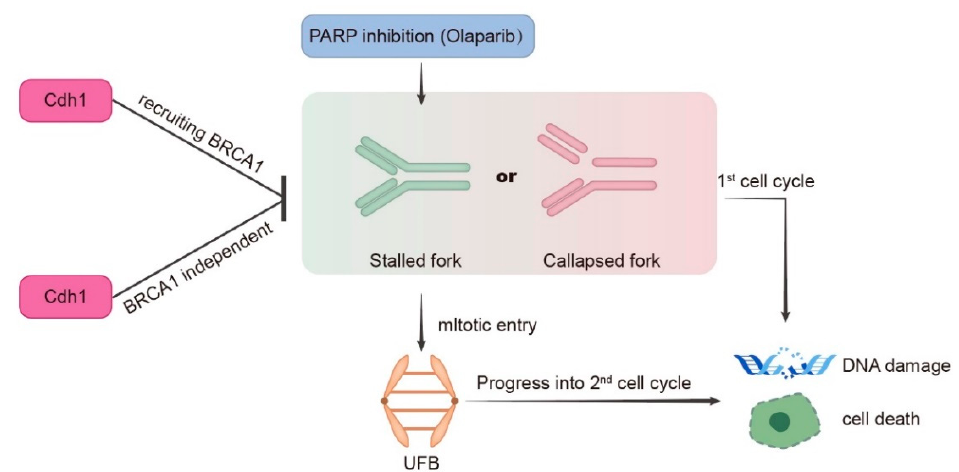
Figure 6. Model for Cdh1 function in genomic stability in response to PARP inhibition. During S phase, PARPi induces stalled or collapsed forks. Cdh1 prevents stalled or collapsed forks accumu- lation either through recruiting BRCA1 or its other functions that are not related to BRCA1. When Cdh1 is absent, excessive stalled or collapsed forks can directly lead to DNA damage and cell death in the first cell cycle; or upon mitotic entry, these abnormal replication structures generate ultrafine DNA bridges, which affects sister chromatids segregation leading to DNA damage and cell death in the next cell cycle.